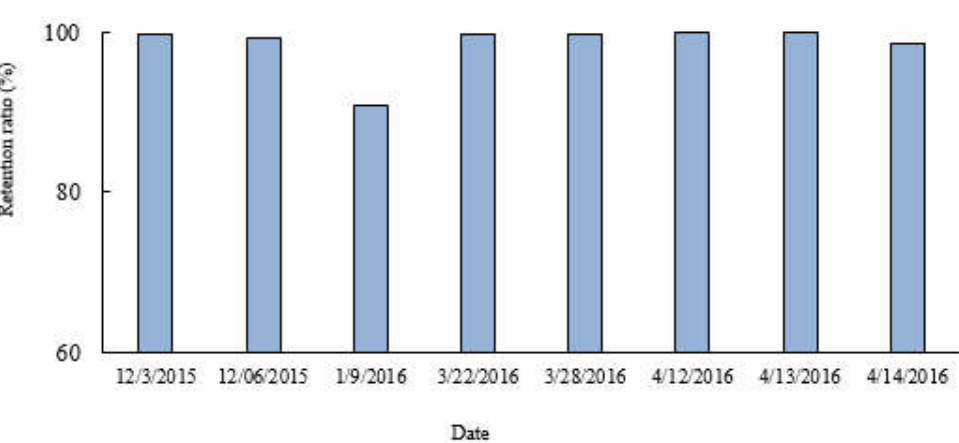
Fig. 6: rain retention rate in some rainfall events in the studied sample green